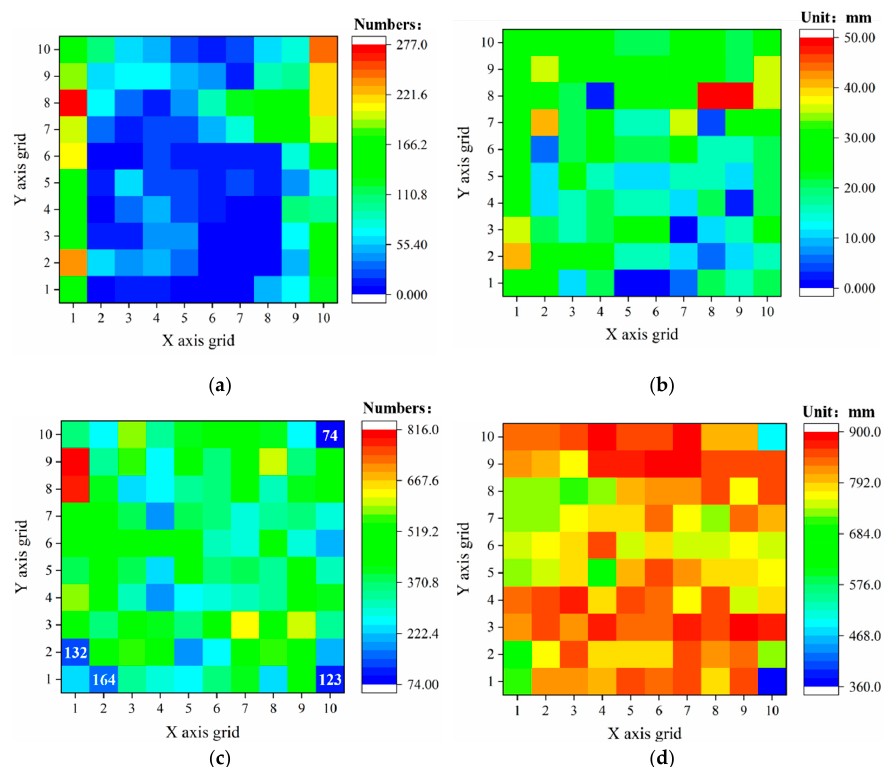
Figure 8. The data of group 1. ( a ) Distribution of the number of ground points in the grid; ( b ) Average elevation of the ground; ( c ) Distribution of the number of crop points in the grid; ( d ) Maximum elevation value of crop points in the grid.